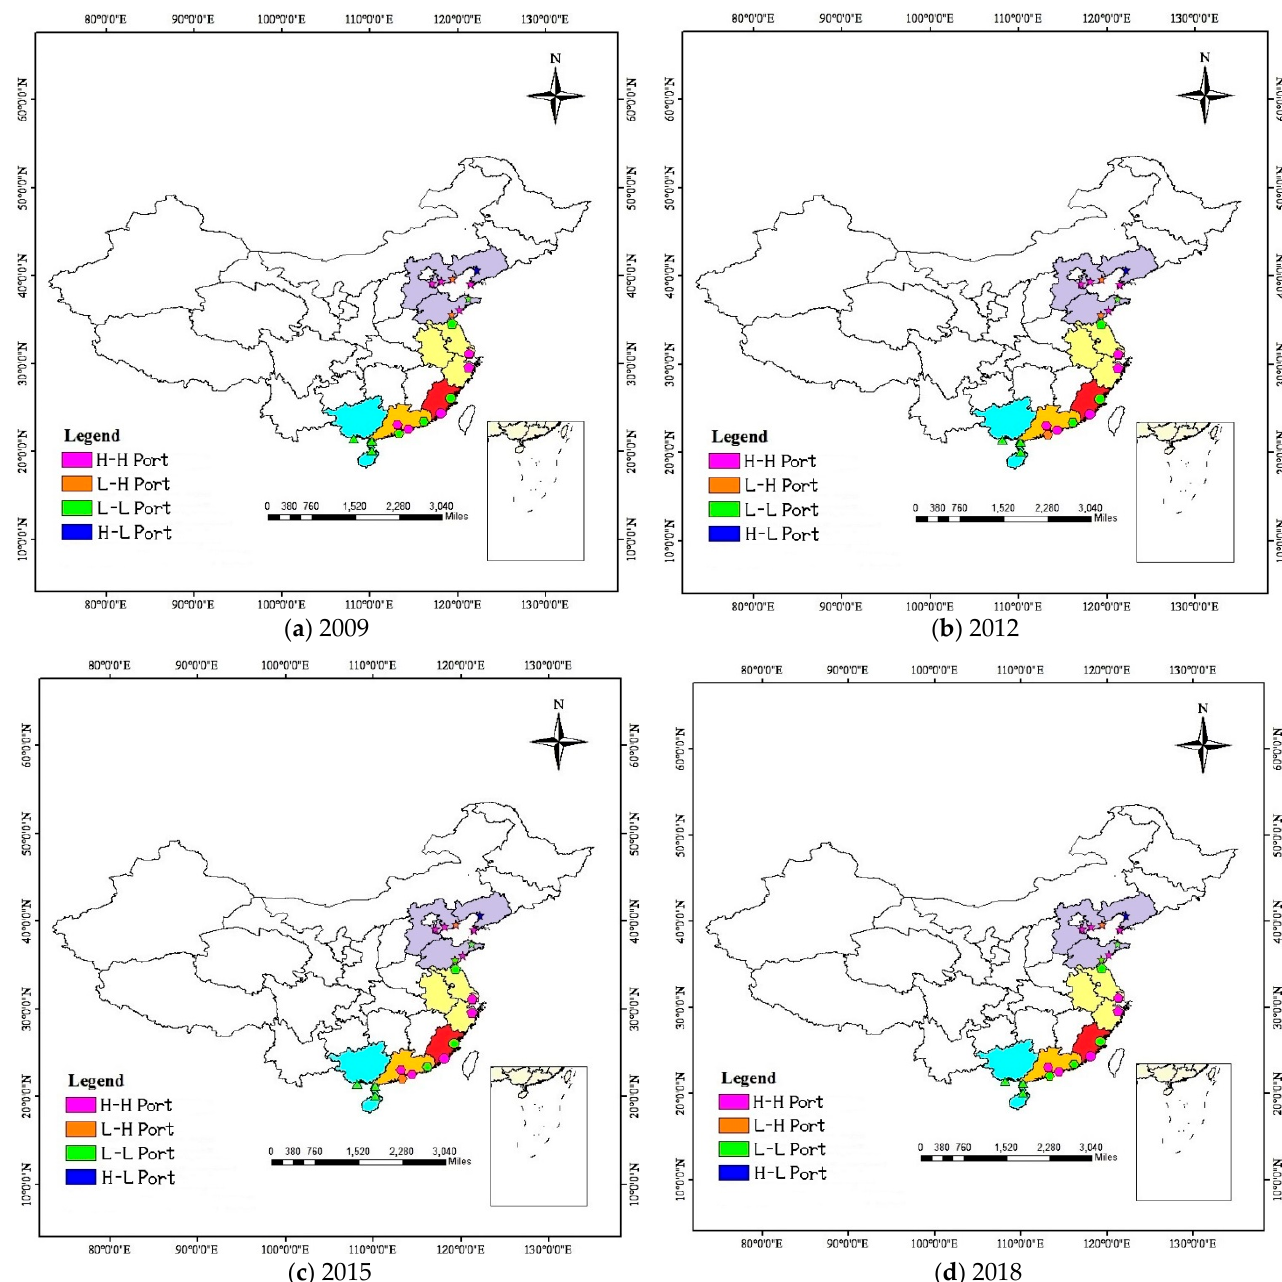
Figure 2. Spatial locations of the Chinese 20 ports in five regions.